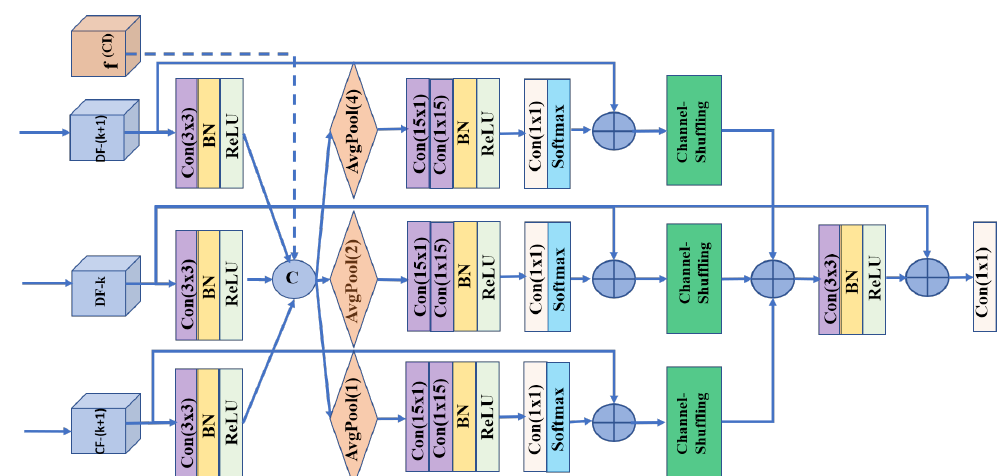
Figure 4. CFlU-k block structure. This example shows CFlU-4, which takes inputs from CF-(k+1), DF-k, and DF-(k+1). CF-k and DF-K denote CFIU and DFIU modules,